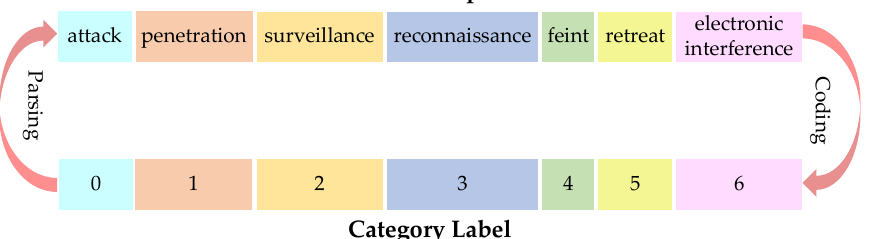
Figure 3. Schematic diagram of combat intention coding and analysis. The same color is a set of correspondences.